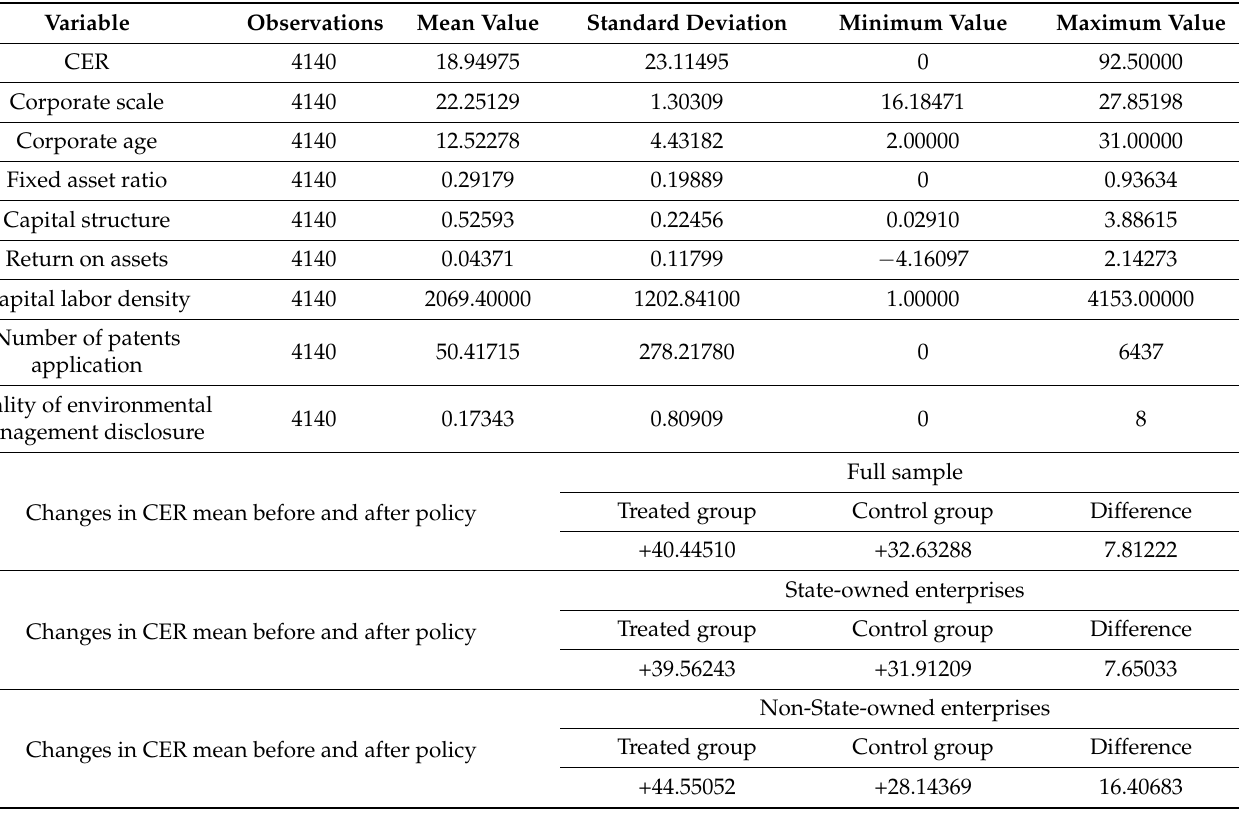
Table 2. Descriptive statistics of the